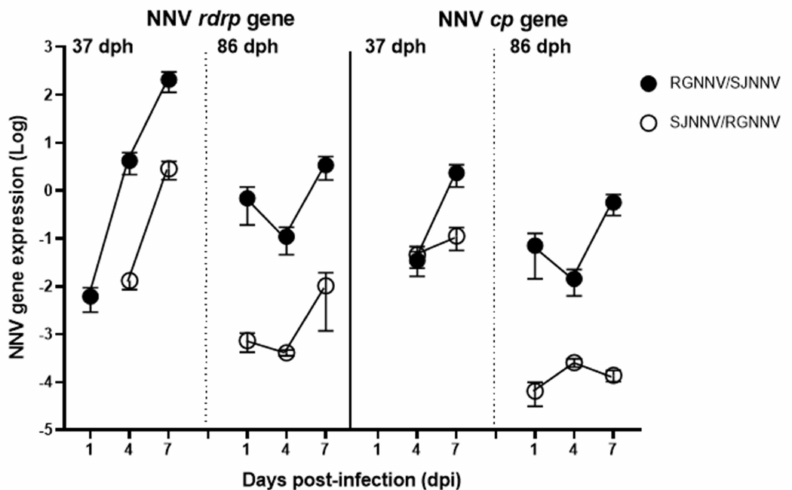
Figure 2. Nodavirus (NNV) reassortants replicate in gilthead seabream larvae. Seabream larvae at 37 or 86 days post-hatching (dph) were infected by immersion with 10 4 TCDI 50 / mL of RGNNV/SJNNV or SJNNV/RGNNV reassortants. The control was a mock-infected group. At 1, 4 or 7 days post- infection (dpi) individual larvae ( n = 5) were sampled and the transcription of the viral RNA- dependent RNA polymerase ( rdrp ) and coat protein ( cp ) genes analysed by real-time PCR. Data represent the mean relative gene expression ± SEM.